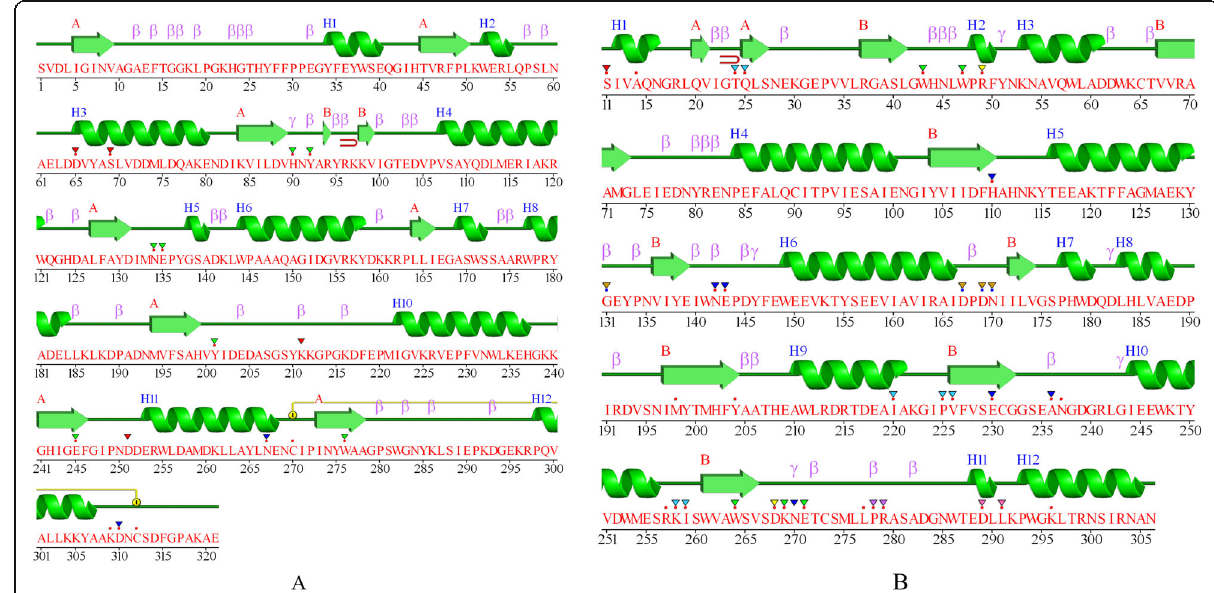
Fig. 5 Schematic wiring diagrams of GH5-cellulase family from uncultured microorganisms. a PDB ID 4EE9. b PDB ID 5I2U. Helices structures labeled with H, strands, and β -turn labeled with A and β , respectively. The disulfide bridge is displayed as a yellow line. β -hairpin is labeled with a red hairpin